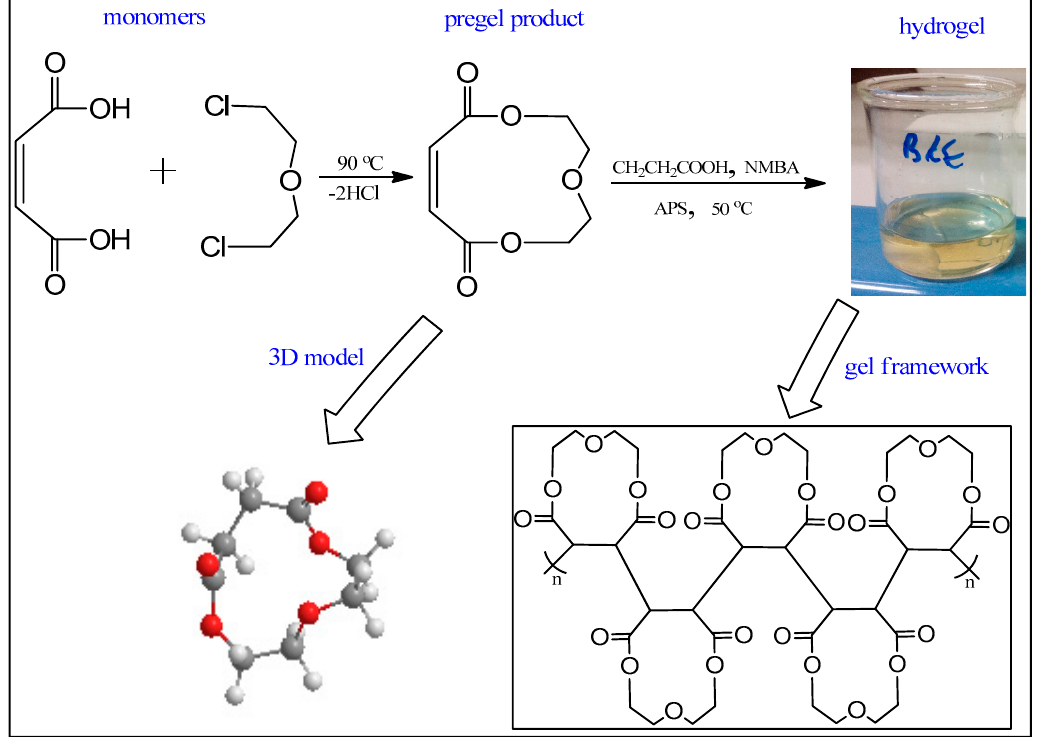
Scheme 1. Proposed synthesis mechanism for BCE hydrogel